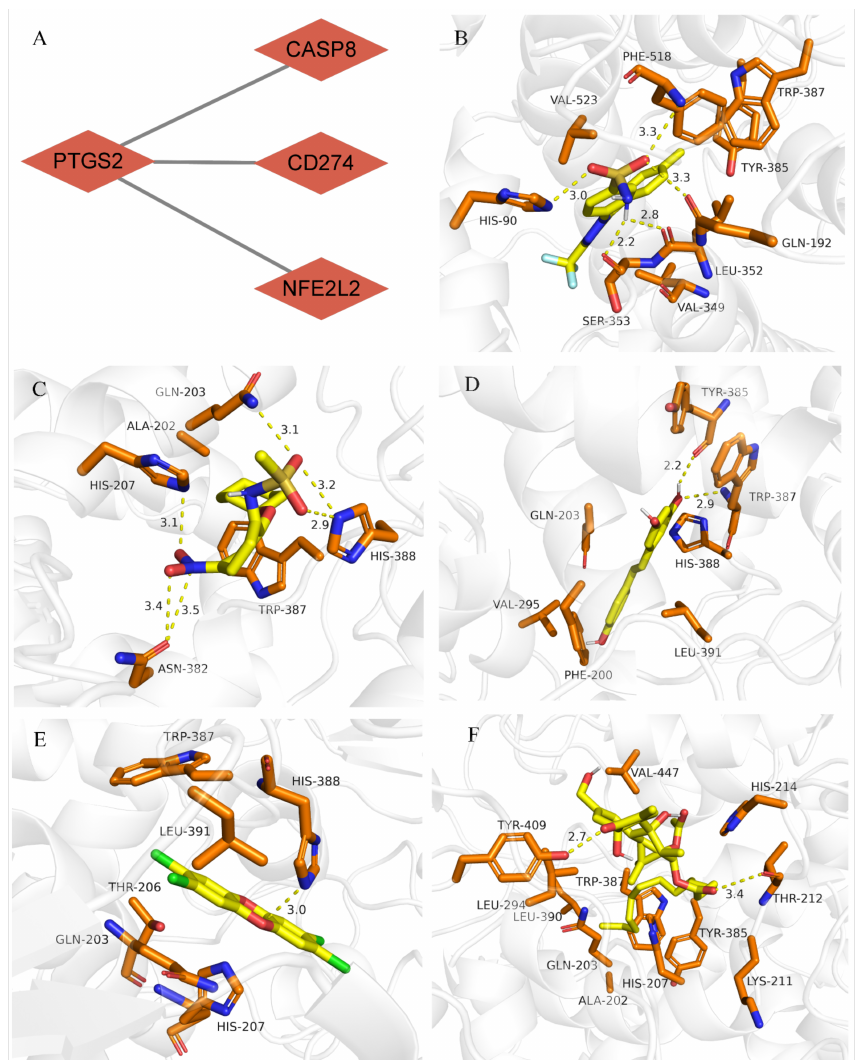
Figure 4. Molecular docking of the core gene PTGS2 with drugs. ( A ) PTGS2 was identified as the core gene; ( B ) Molecular docking of PTGS2 and celecoxib; ( C ) Molecular docking of PTGS2 and N -(2- cyclohexyloxy-4-nitrophenyl)methanesulfonamide; ( D ) Molecular docking of PTGS2 and resveratrol; ( E ) Molecular docking of PTGS2 and tetrachlorodibenzodioxin; ( F ) Molecular docking of PTGS2 and tetradecanoylphorbol